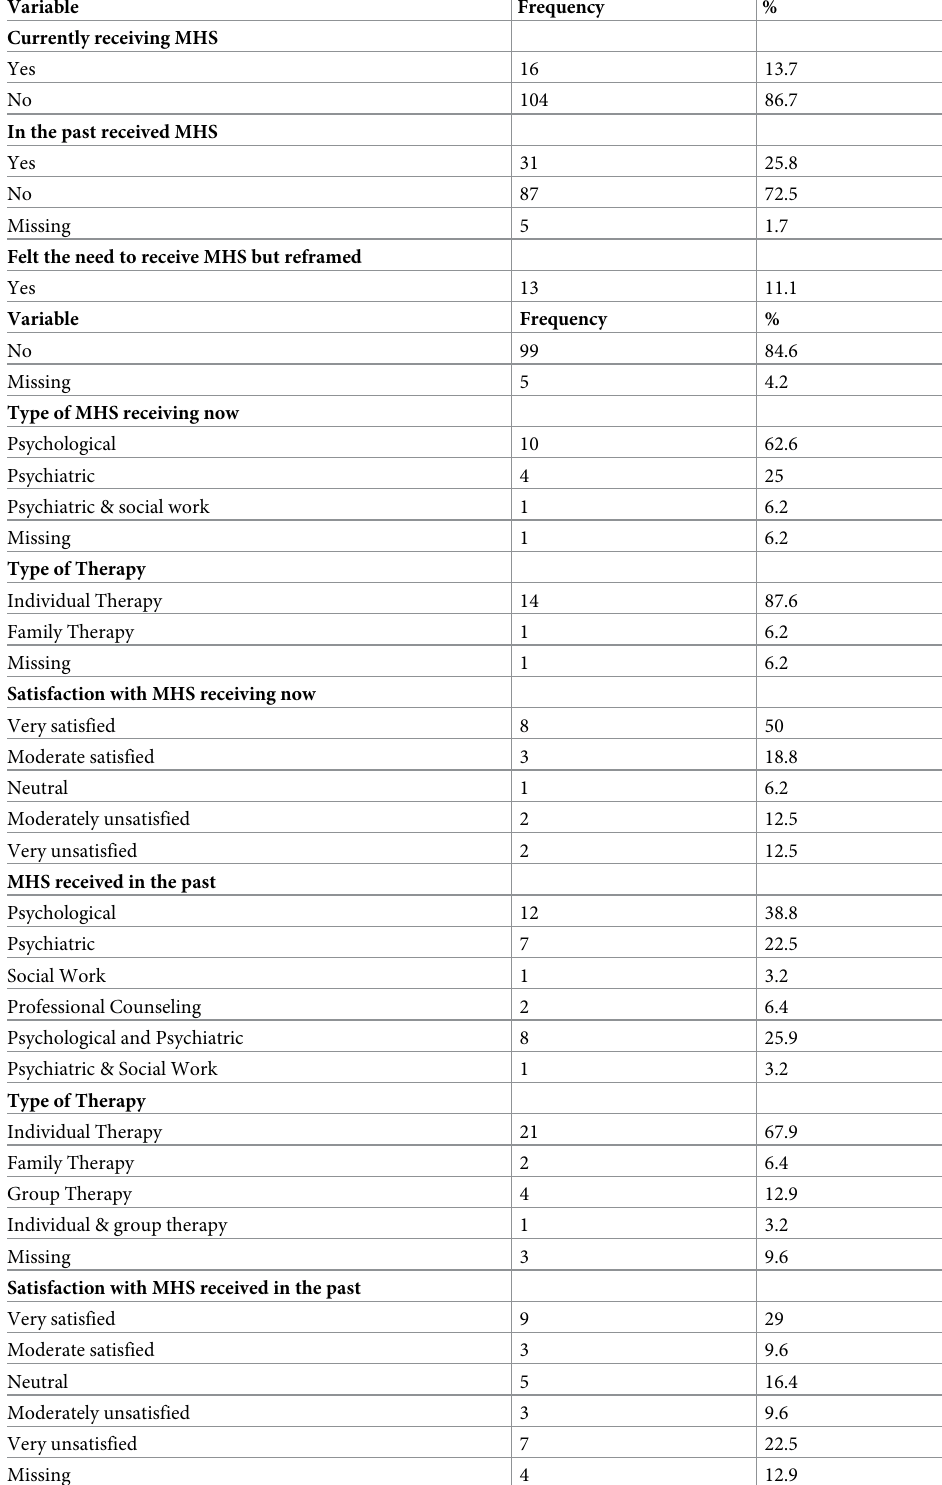
Table 2. Mental health service (MHS) use and satisfaction (n =